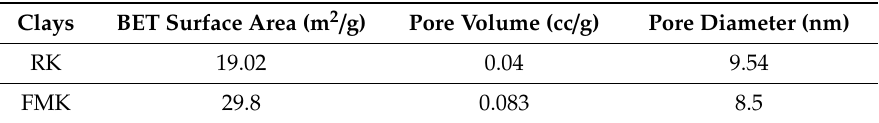
Table 2. Brunauer, Emmett, and Teller (BET) surface area, pore volume, and pore diameter of the raw kaolin (RK) and FMK.